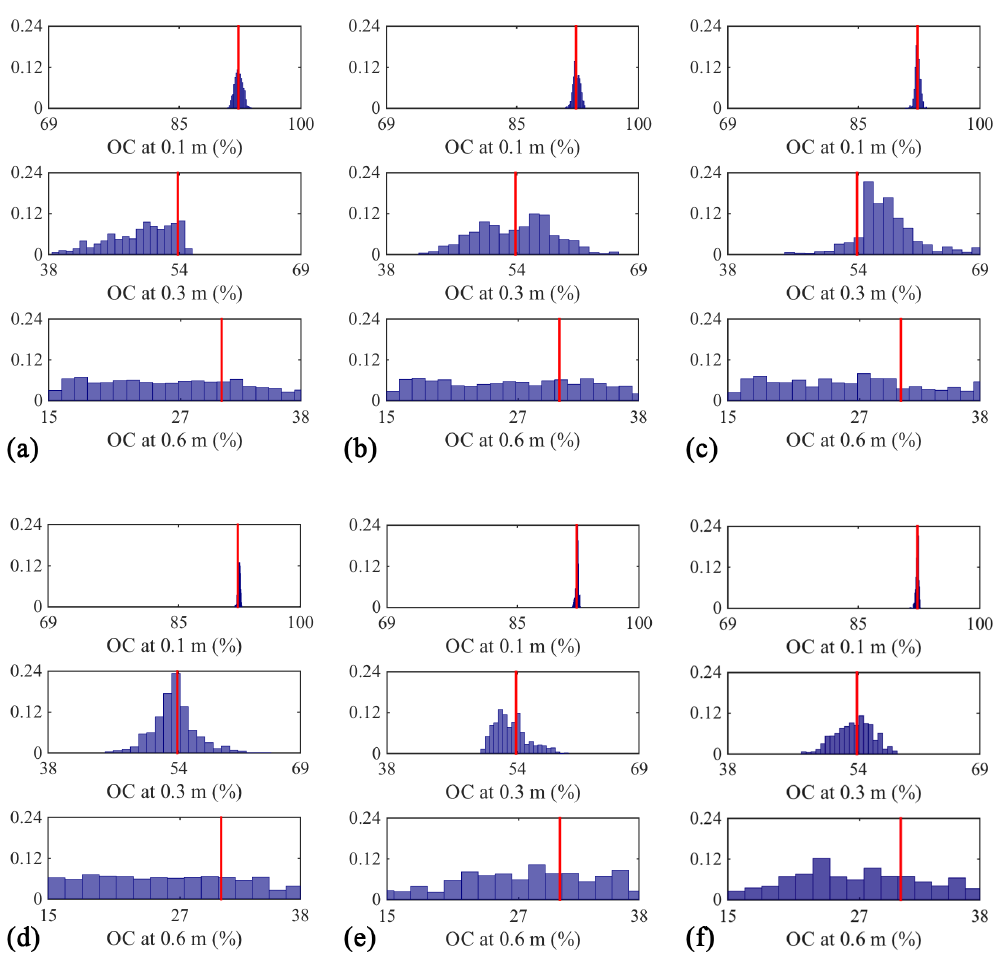
Figure 8. The a posteriori probability of the soil OC content at z = 0 . 1, 0.3 and 0.6m. These probability functions were constructed from 5000 MCMC samples. Measurement errors of apparent resistivity, temperature and liquid water content data are 5%, 0.5 ◦ C and 0.08, respectively. The red lines represent the “true” soil OC content. (a) Scenario 2: ERT; (b) scenario 3: temperature; (c) scenario 4: liquid water